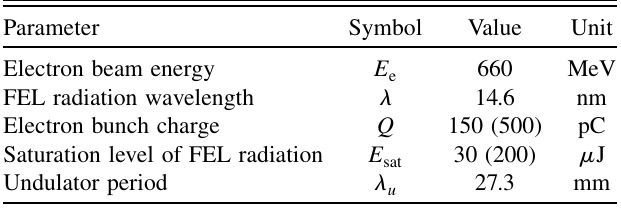
TABLE I. Parameters for the comparative measurements of FEL photon pulse durations and electron bunch lengths. The numbers in the brackets of the electron bunch charge and the FEL radiation saturation level are related to each